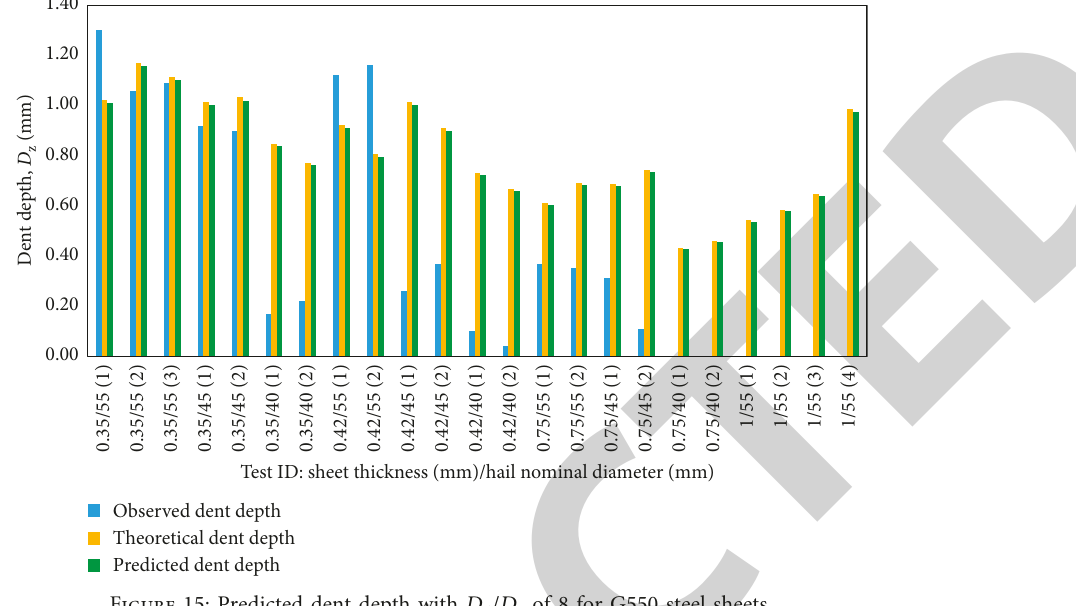
D d / z of 8 for G550 steel sheets.